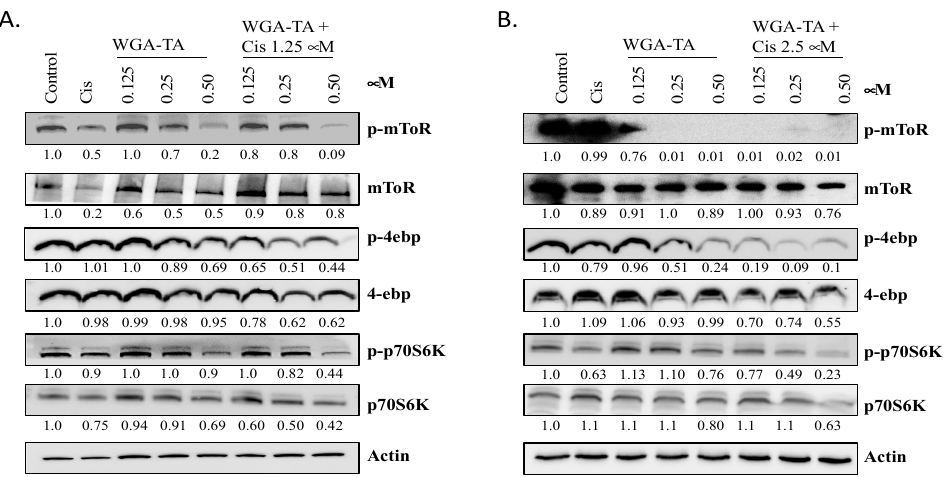
Figure 2. ( A , B ). Western blot showing treatment effect on the mTOR pathway and downstream substrates. MDA1986 cells were treated with varying concentrations of WGA-TA alone or in com- bination with 1.25 ( A ) or 2.5 ( B ) μ M cisplatin as well as cisplatin alone for 24 h. Solvent treated cells were used as control. Cells were collected, lysed, and immunoblotted for mTOR pathway proteins.